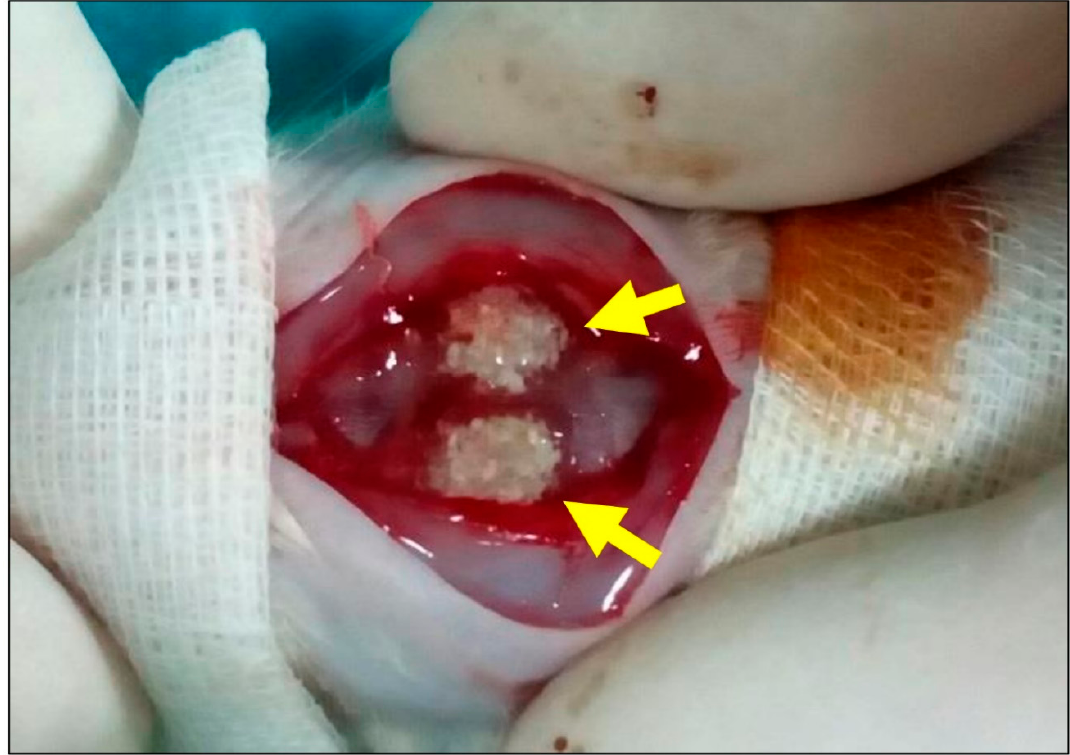
Figure 5. Sample image of the surgical procedure. Two calvarial defects (arrows) filled with biphasic bone substitute combined with the low HMWHY concentration.